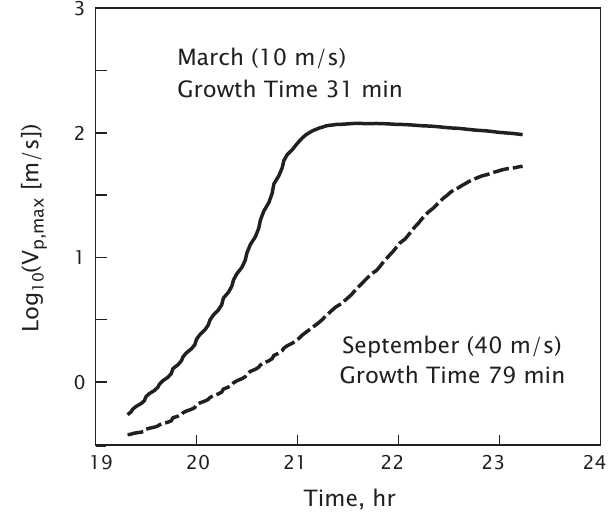
Fig. 6. Time evolution of upward bubble velocity for the two cases, corresponding to the equinoxes for September 2004 and March